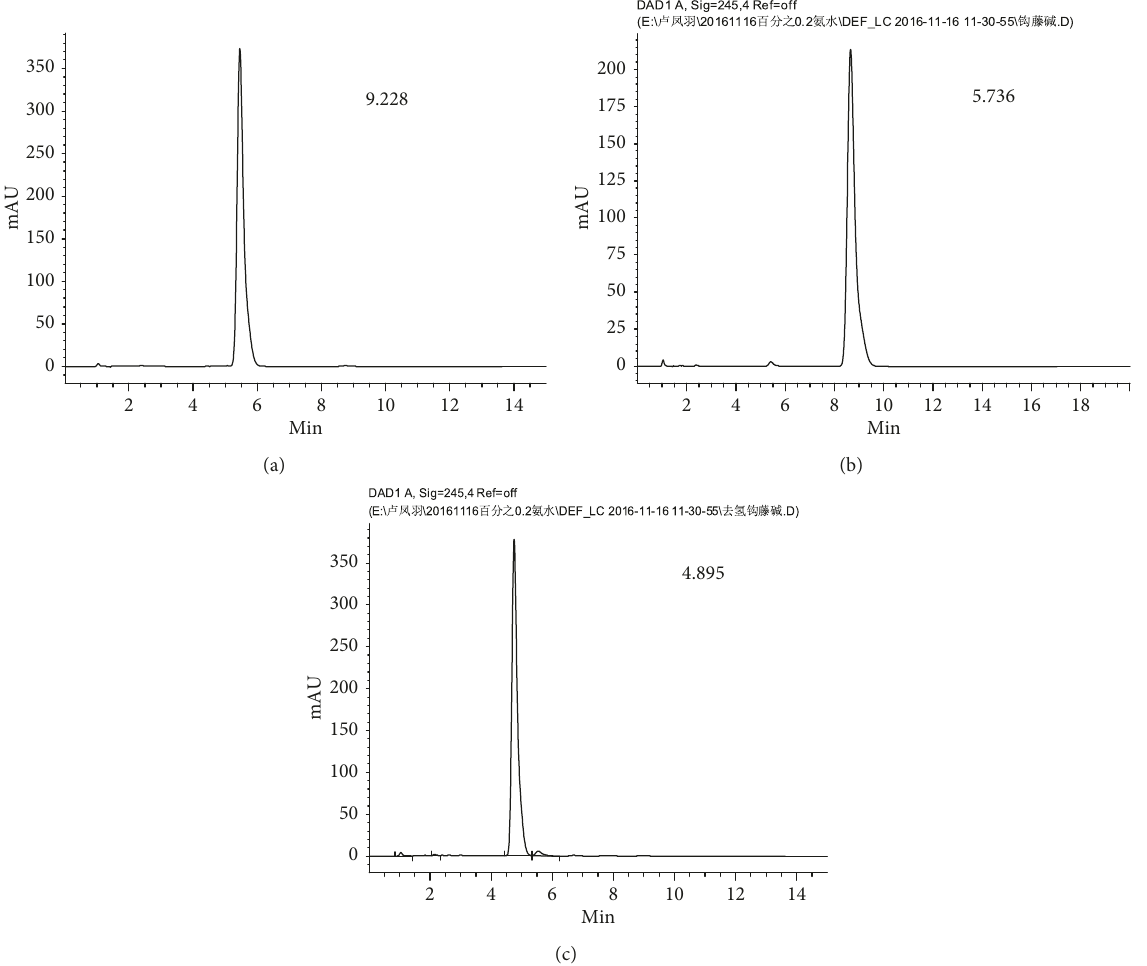
Figure 2: HPLC spectrum of standard solution. (a) Rhynchophylline , (b) isorhynchophylline , and (c) corynoxeine .